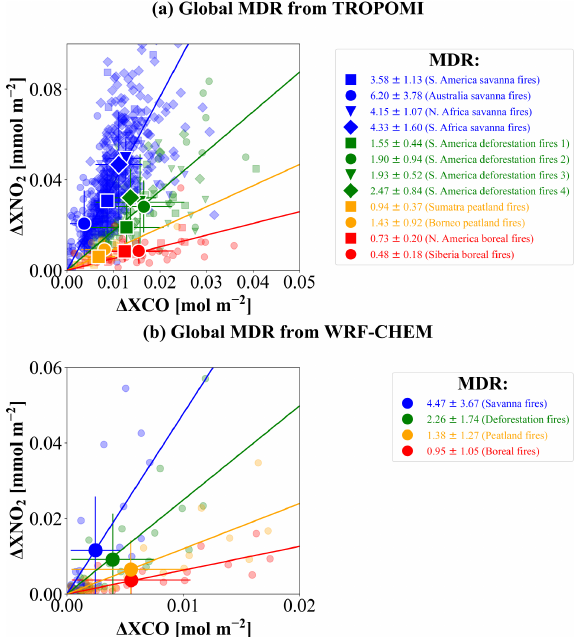
Figure 6. In panel (a) , the relationship between daily (cid:49)X CO (molm − 2 ) and (cid:49)X NO 2 (mmolm − 2 ) from TROPOMI combined for all regions of this study. The region average relationship between (cid:49)X CO and (cid:49)X NO 2 is depicted by the big markers together with error bars to indicate the 1 σ day-to-day variability. The four regres- sion slopes with intercept at zero signify the different groupings of combustion efficiency. The legend includes the average MDR and 1 σ day-to-day variability estimates for each region. For the South American deforestation regions, we used data in September, at the height of the 2018 fire season. In panel (b) , the relationship between daily (cid:49)X CO and (cid:49)X NO 2 and the monthly average MDR from four different synthetic WRF-Chem simulations (see Sect.